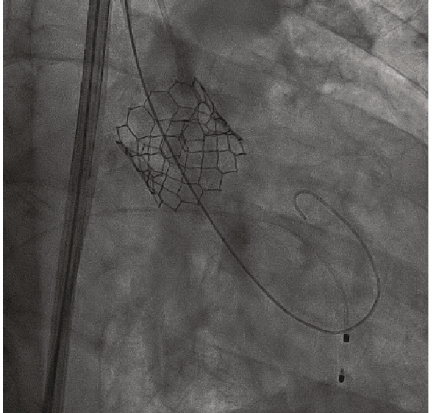
Figure 2: Showing deployed Sapien 3 valve.